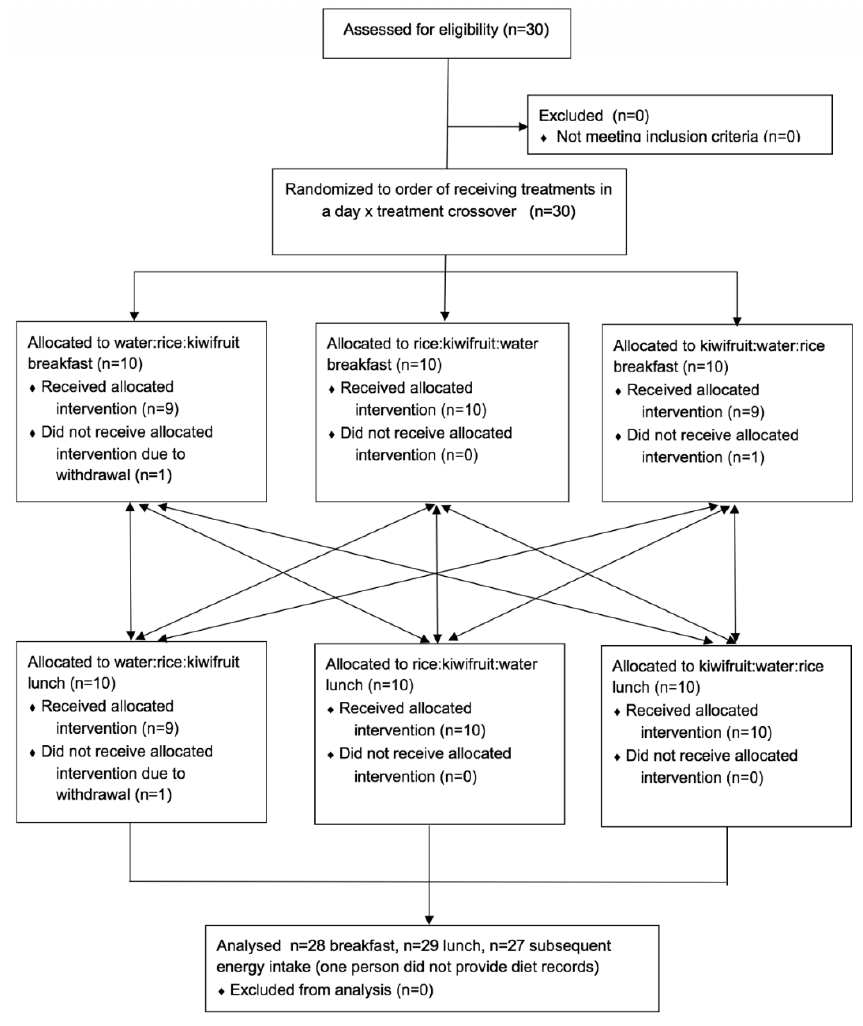
Figure 2. Participant flowchart.